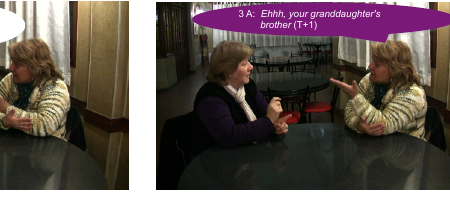
Figure 22. ‘Who?’, secondly in line 2 Person B (left) initiates repair with a content question word combined with eyebrows together.